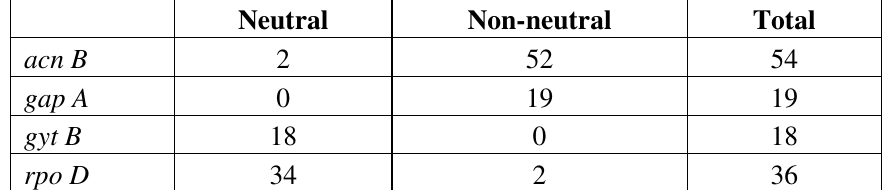
Table 5. Neutral and non-neutral polymorphism between Xanthomonas arboricola pv. juglandis strains isolated from walnut “apical necrosis” of fruits and the other strains according to the Mc Donald-Kreitman test. The test provides the ratio between non-synonymous amino acids and synonymous amino